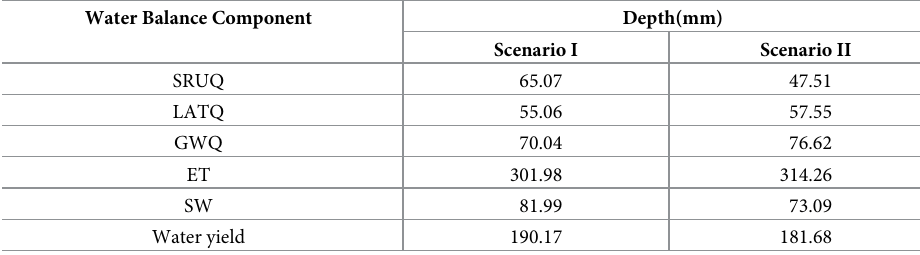
Table 8. Average annual water balance